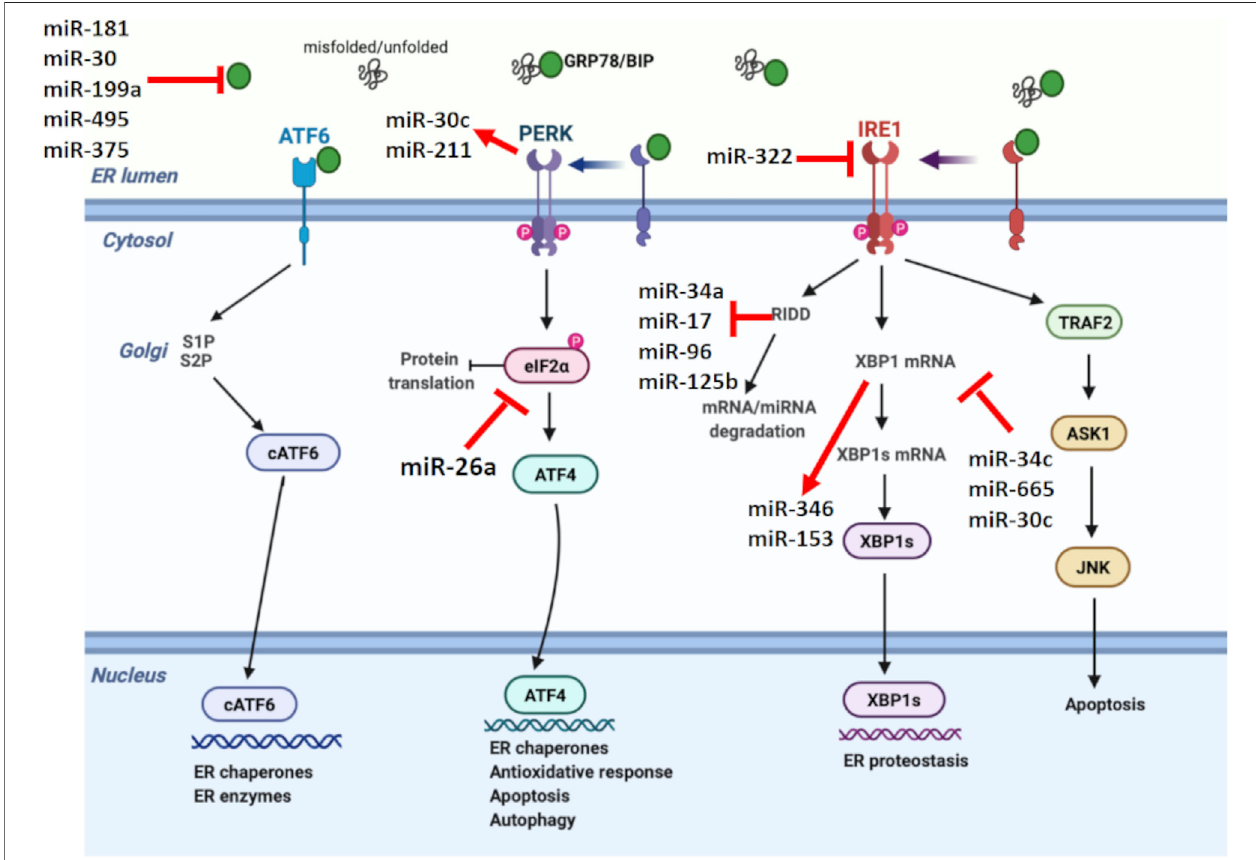
FIGURE 2 | Unfolded protein response signaling with their regulating microRNAs. miRNAs have a crucial role in shaping the UPR, while miRNA expression is also regulated by UPR. miR-181, miR-30, miR-199a, miR-495, and miR-375 negatively regulates GRP78. On the other hand, miR-322 suppresses IRE1. XBP1 and RIDD signaling, members of IRE1 branch in UPR, regulate miR-153, miR-346, miR-34a, miR-17, miR-96, and miR-125b. Additionally, miR-34c, miR-665, and miR-30c are knowntotargetXBP1,whilemiR-26asuppresseseIF2 α ,reducingtheproteintranslation.CertainmiRNAsalsoformalinkbetweenUPRbranches.Inthisdirection, PERK-mediated miR-30c activation inhibits XBP1 pathway and establishes a negative crosstalk between PERK and IRE1 branches of UPR.